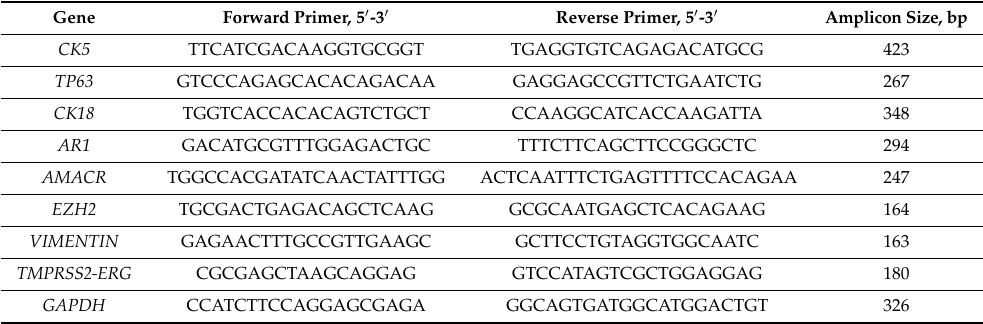
Table 2. Primers for amplification of cancer, epithelial, and mesenchymal markers in prostate tissues and derived